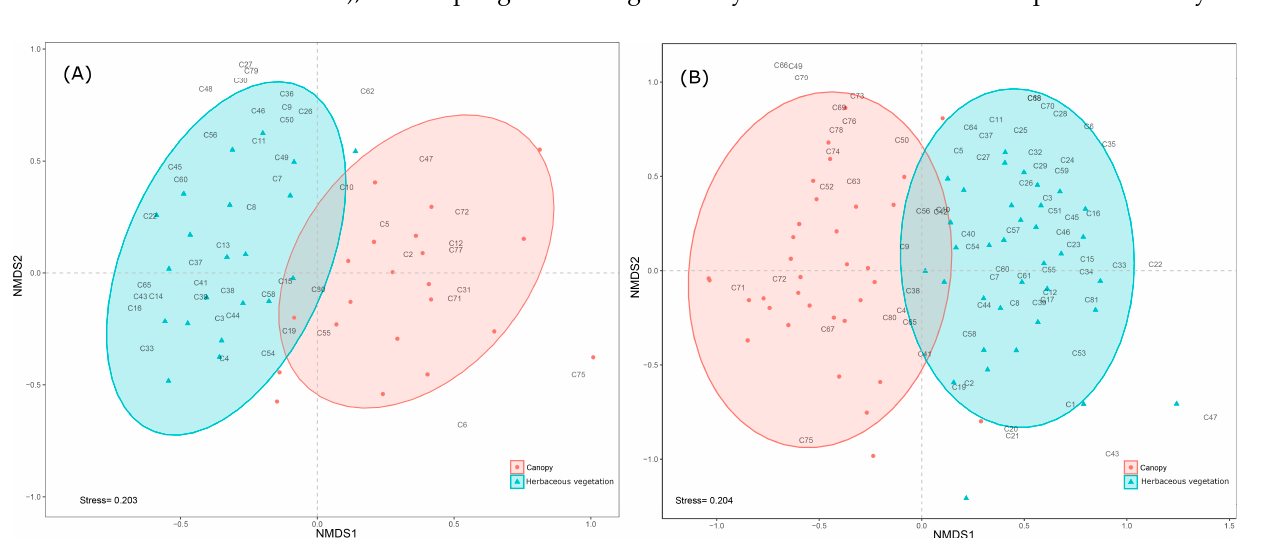
Figure 1. Non ‐ metric multidimensional scaling (NMDS) analysis for Cicadomorpha abundance in Figure 1. Non-metric multidimensional scaling (NMDS) analysis for Cicadomorpha abundance in the the canopy and inter ‐ row vegetation in ( A ) 2018 and ( B ) 2019. The numbers within the panels canopy and inter-row vegetation in ( A ) 2018 and ( B ) 2019. The numbers within the panels correspond correspond to the numbers of the species/morphospecies in Table 1. to the numbers of the species/morphospecies in Table